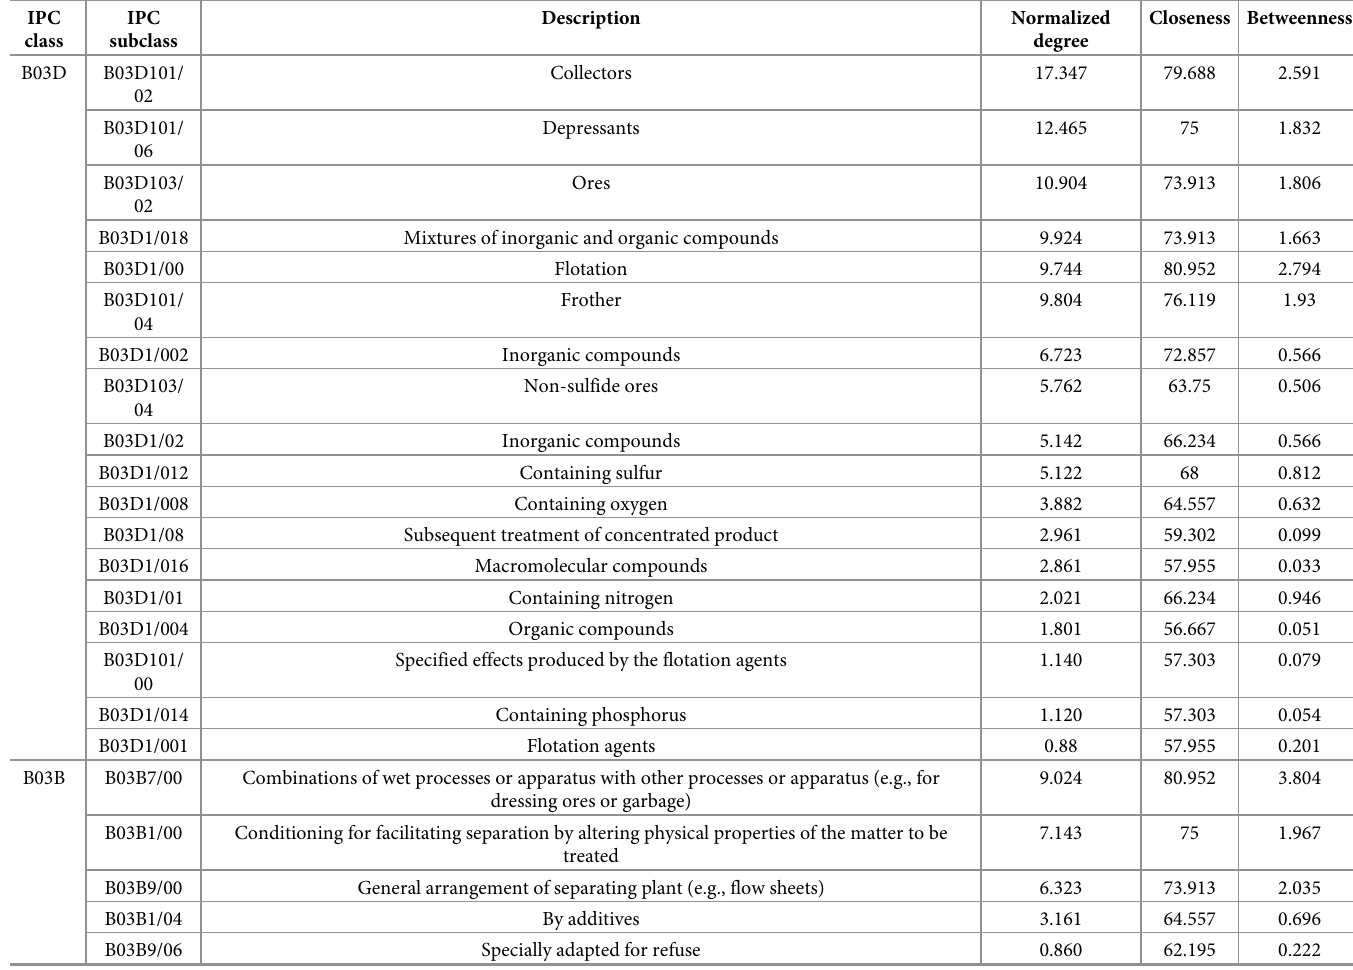
Table 3. IPC correlation and measurement